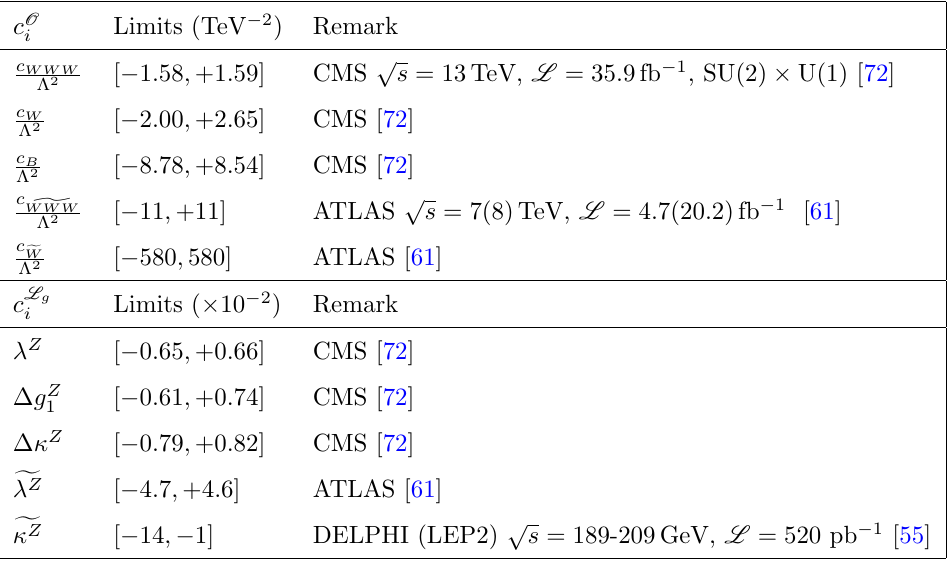
Table 1 . The list of tightest constraints observed on the e(cid:11)ective operators and the e(cid:11)ective vertices in SU(2) U(1) gauge at 95% C.L. from (cid:2)